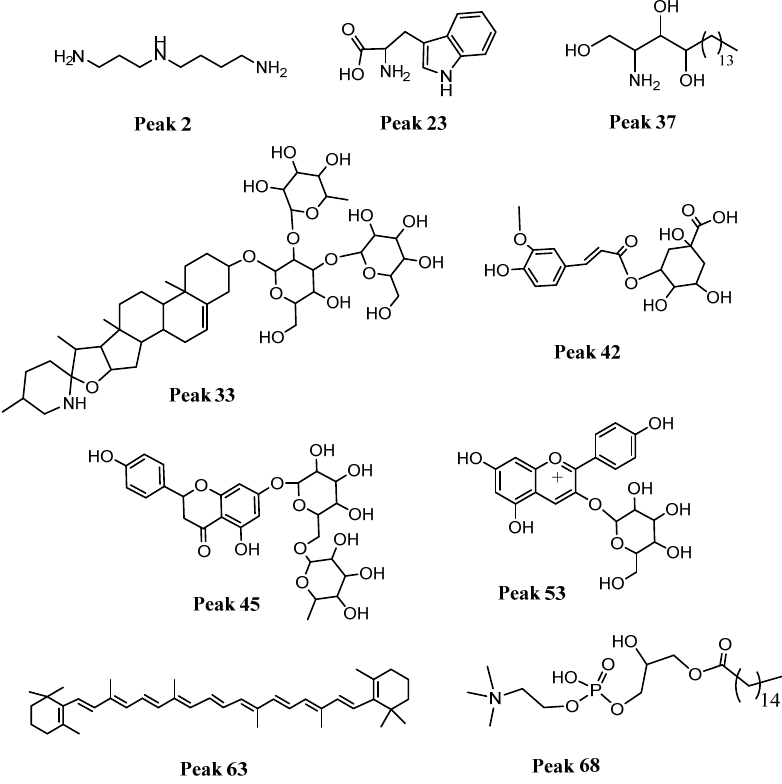
Figure 3. Structures of some representative compounds detected in cocona ecotypes: spermidine, peak 2, the aminoacid triptophan, peak 23, phytoesphingosine peak 37, s pirosol ‐ 5 ‐ en ‐ 3 ‐ ol, 3 ‐ O ‐ [rhamnosyl ‐ glucosyl] ‐ galactoside, peak 33, 3 ‐ O ‐ feruloylquinic acid, peak 42, naringenin 7 ‐ O ‐ rutinoside, peak 45, pelargonidin 3 ‐ O ‐ glucoside, peak 53, B ‐ carotene, peak 63 and 1 ‐ hexadecanoyl ‐ sn ‐ glycero ‐ 3 ‐ phosphocholine, peak 68. Table 3. High resolution UHPLC ‐ PDA ‐ ESI ‐ OT ‐ MS identification of metabolites in fractions of cocona fruits (a–e): NMA1, SRN9, CD1, CTR, UNT2 ecotypes, respectively.